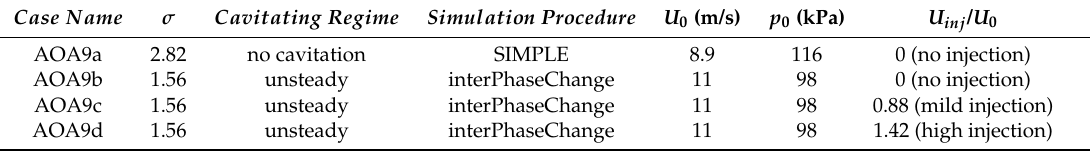
Table 2. Simulation details corresponding to angle of attack 9 ◦